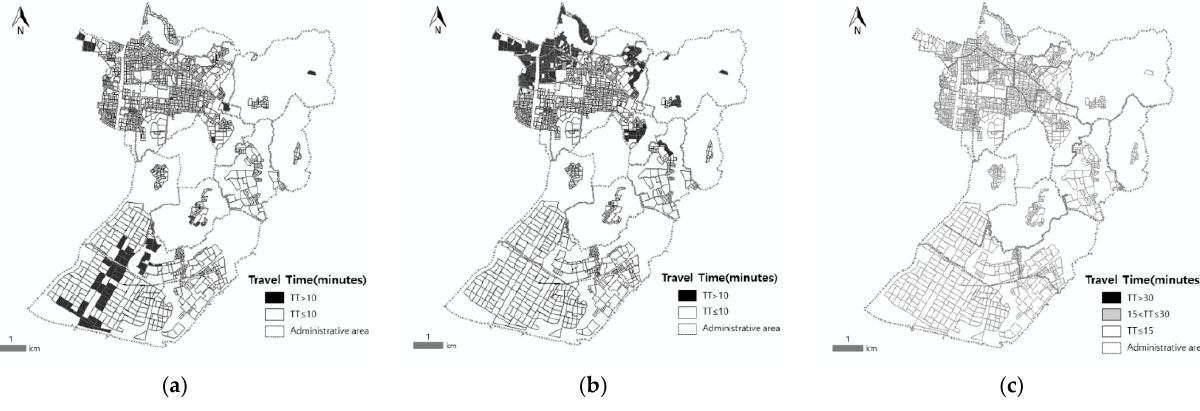
Figure 6. Maps of residential areas with poor access—veh i cle time: ( a ) city library; ( b ) city park; ( c ) sports facility. Table 5. Population by legend—walking time.